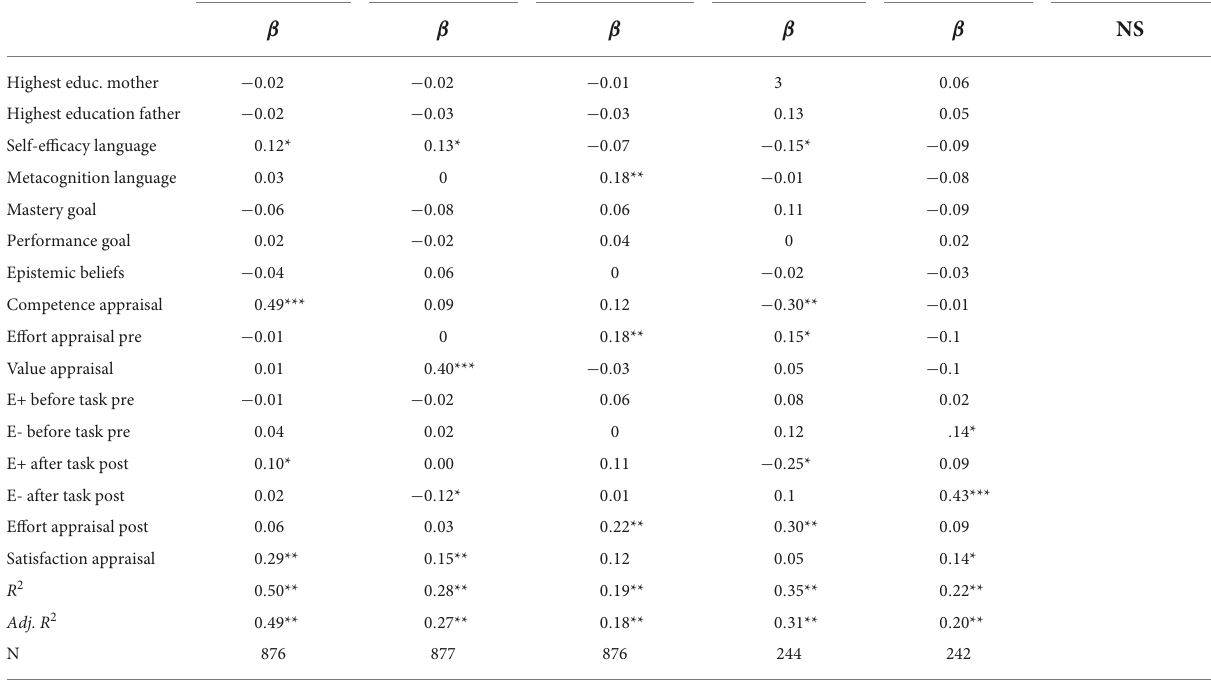
TABLE 5 Summary of stepwise multiple regressions predicting the three attributions for the Good (G) and the Poor (P)